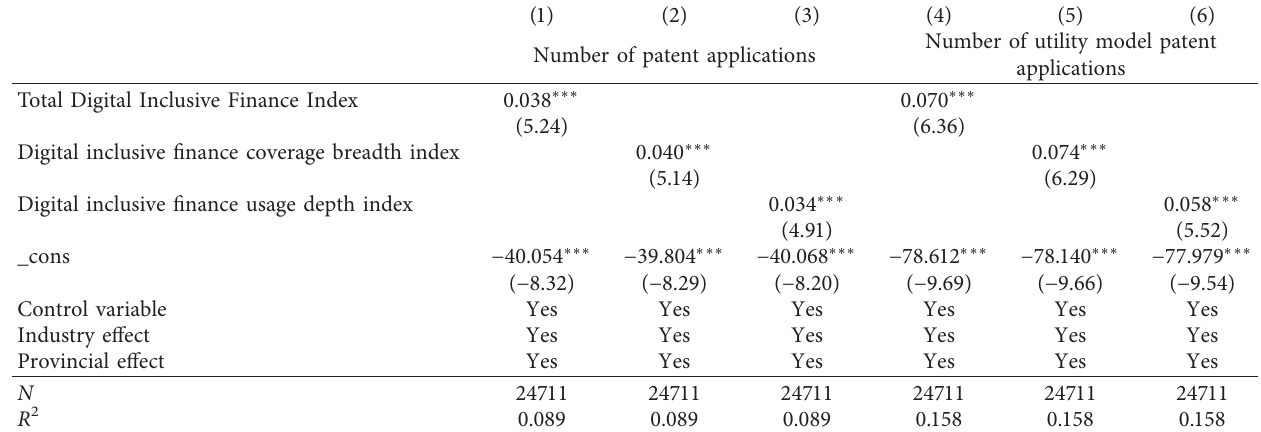
Table 3: Least squares method for controlling provinces and